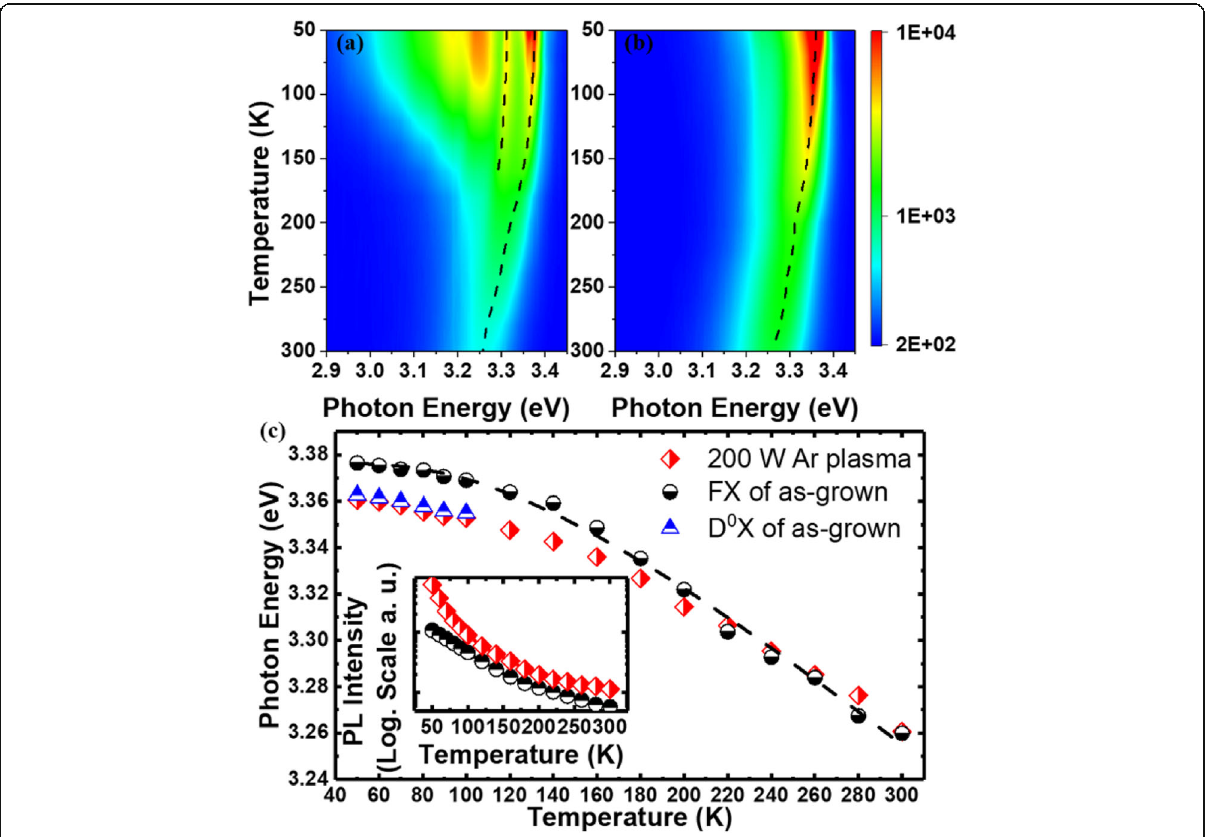
Fig. 4 a , b Temperature-dependent PL spectra of the As-grown ZnO NWs and irradiated by 200 W Ar plasma. c Photon energy and PL emission from the as-grown sample